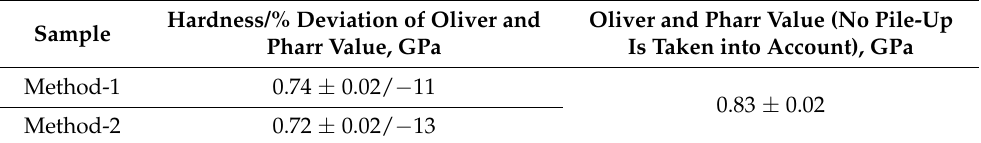
Figure 10. Stress ‐ strain curves of annealed and H58 DHP Cu. The H58 cold ‐ rolling process reduced the DHP Cu plastic strain behavior by 35%, from  = 62.5 to 42%. At the same time, the two methods of pile ‐ up calculation by nanoindentation showed a hardness deviation reduction from the annealed to cold ‐ rolled state of 31–35%. That is, a straightforward relationship can be found between the nanoindentation pile ‐ up imprint, and the corresponding ductility variation induced by